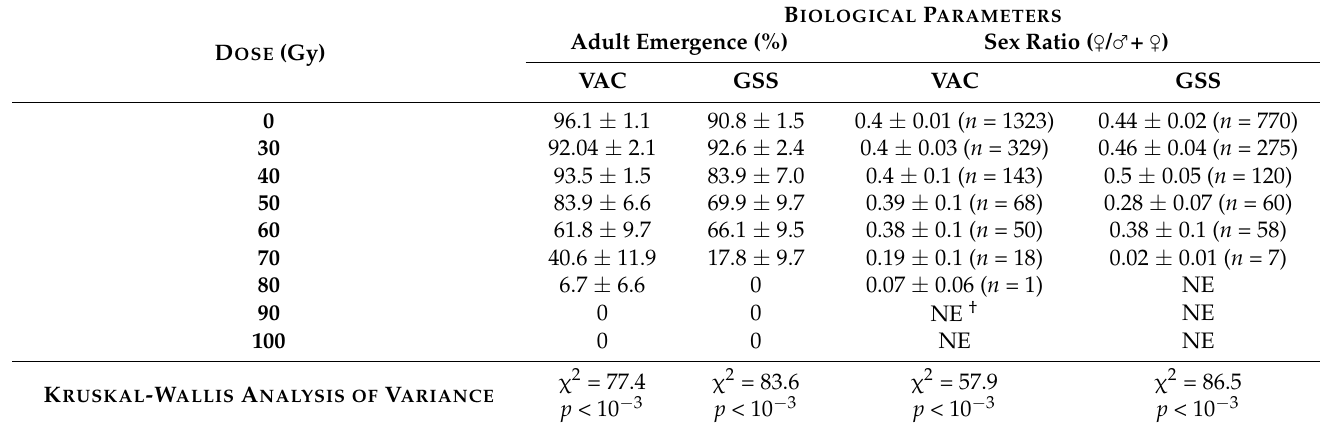
Table 3. Means ( ± SE) of adult emergence and sex ratio of flies originated from crosses between fertile females and Anastrepha fraterculus males from a bisexual strain (VAC) and a genetic sexing strain (GSS) irradiated under hypoxia. Total numbers of scored adults are in